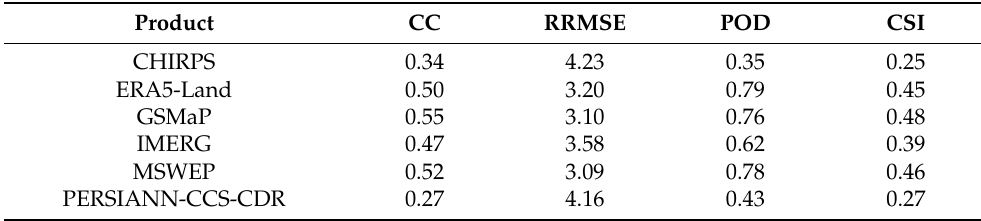
Table 2. Mean values of CC, RRMSE, POD and CSI of six products based on all observations between 2015 and 2019. We collected all corresponding samples and calculated the statistics at once to avoid unstable statistics caused by too few precipitation samples on some days. Product CC RRMSE POD CSI CHIRPS